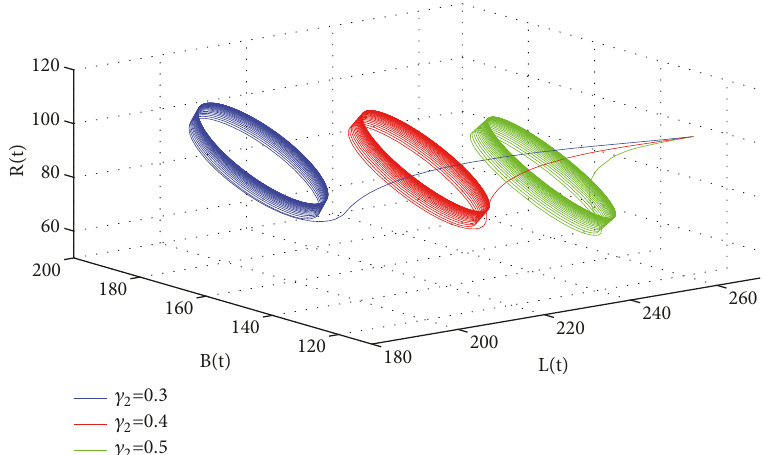
Figure 10: Dynamic behavior of system (61): projection on L-B-R with 𝜏 = 3.6755 > 𝜏 0 = 3.4685 for different 𝛾 2 . Rest of the parameters are taken as given in the text.